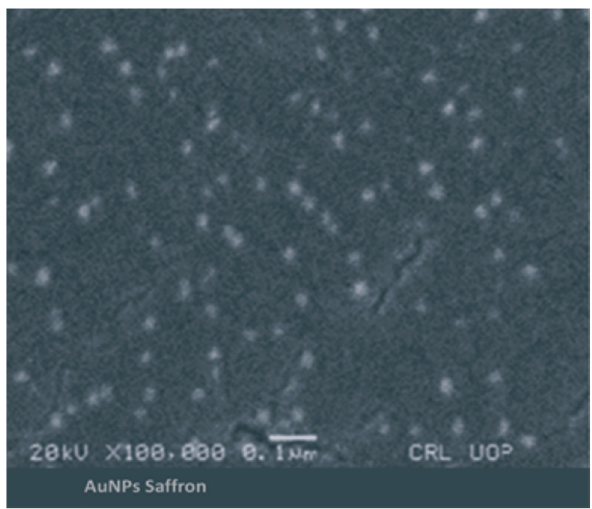
Figure 13: Scanning electron microscopic ( SEM ) image of sa ff ron - loaded AuNPs ( SS - AuNPs ) .